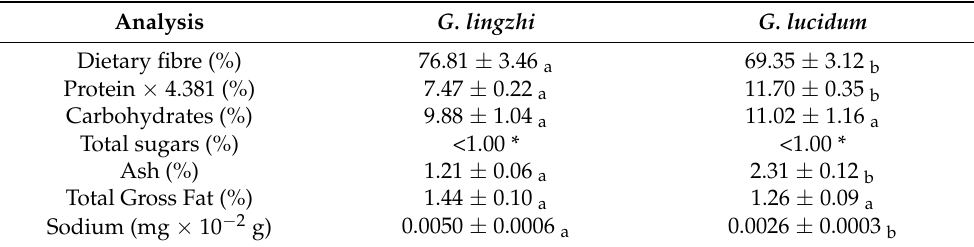
Table 2. Nutritional comparative chart (per 100 g of product) between GZ carpophores from industrial crops in Shenzhen (China) and GL carpophores obtained by cultivation of the Iberian strain GLM from Madrid (Spain), grown on Substrate 2:20% rye and 80% Pyrenean